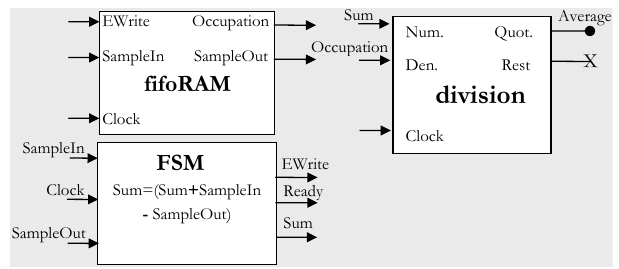
Fig. 9. Core arithmetic average version.